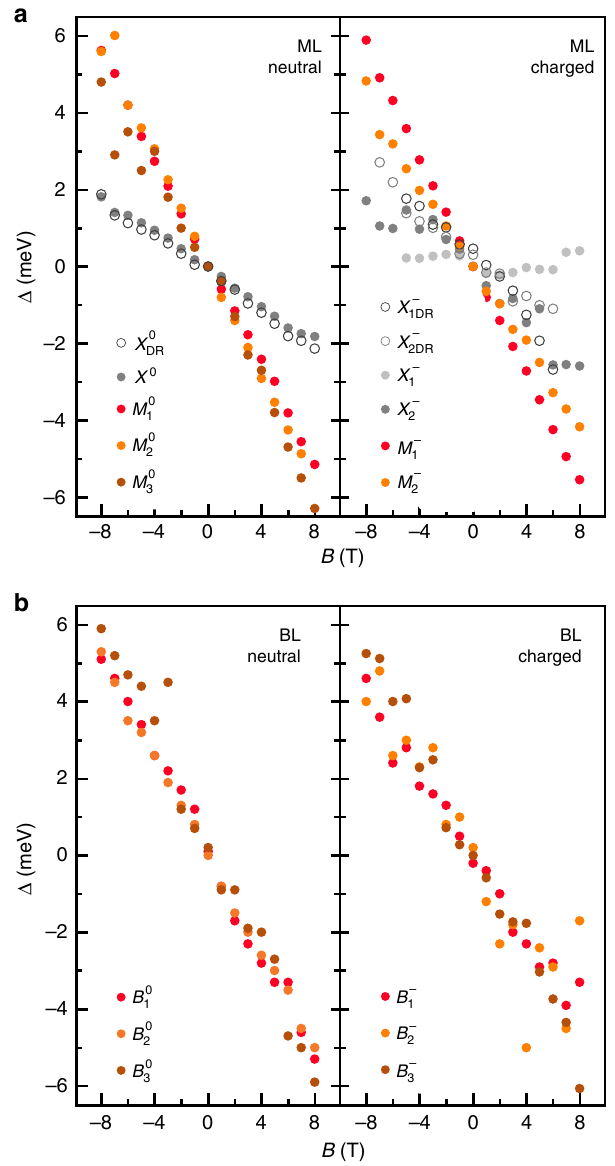
Fig. 3 Valley Zeeman splittings in charge-controlled monolayer and bilayer WSe 2 . a , b Valley Zeeman splitting Δ as a function of the magnetic fi eld for the photoluminescence peaks (closed circles) of monolayer and bilayer WSe 2 in the neutral (left panel) and negatively charged (right panel) regimes. Complementary data (open circles) were obtained from polarization-resolved re fl ectivity.